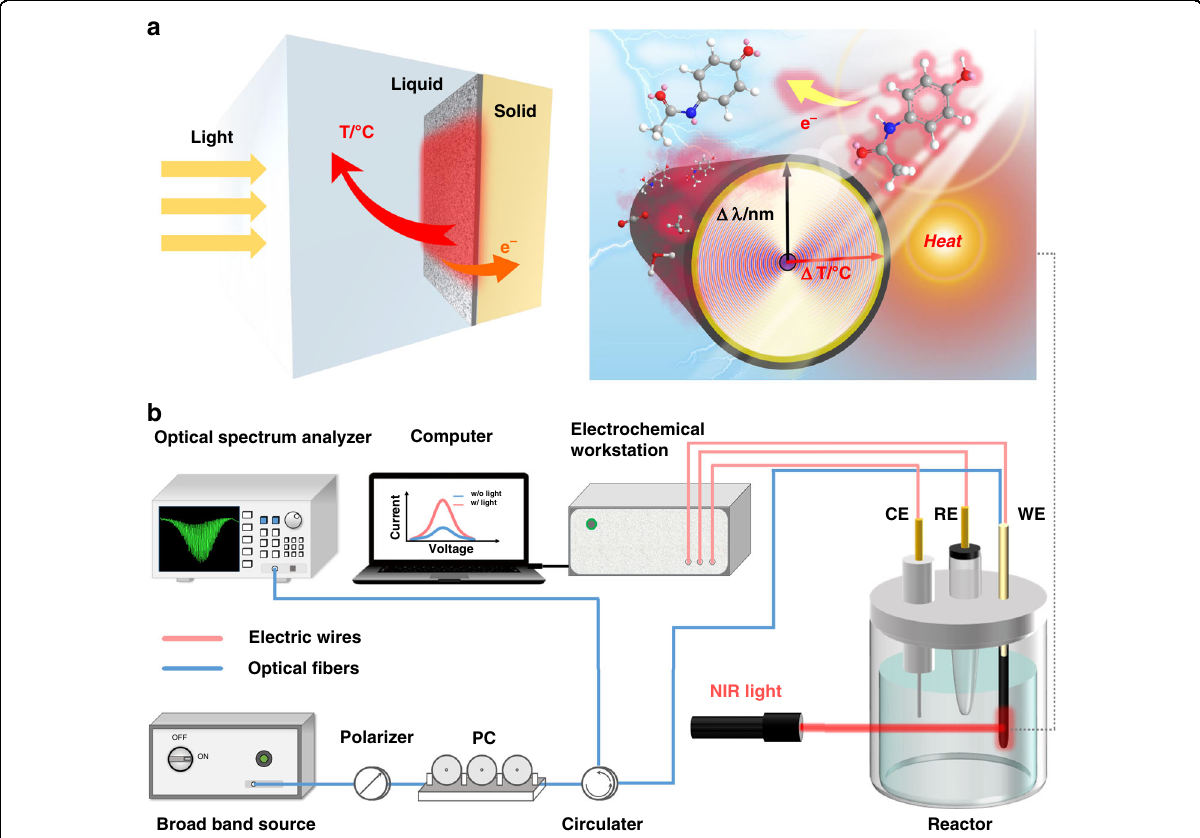
Fig. 1 Concept of operando monitoring thermal effects in photo-involved catalytic reactions via an optical fi ber. a Photothermal effect in photo-involved catalytic reactions. Δ T is the photo-induced temperature increase at catalyst interface and Δ λ is the wavelength shift of cladding mode resonance. b Optical fi ber sensing principle and system for operando monitoring light-to-heat at liquid-solid catalyst